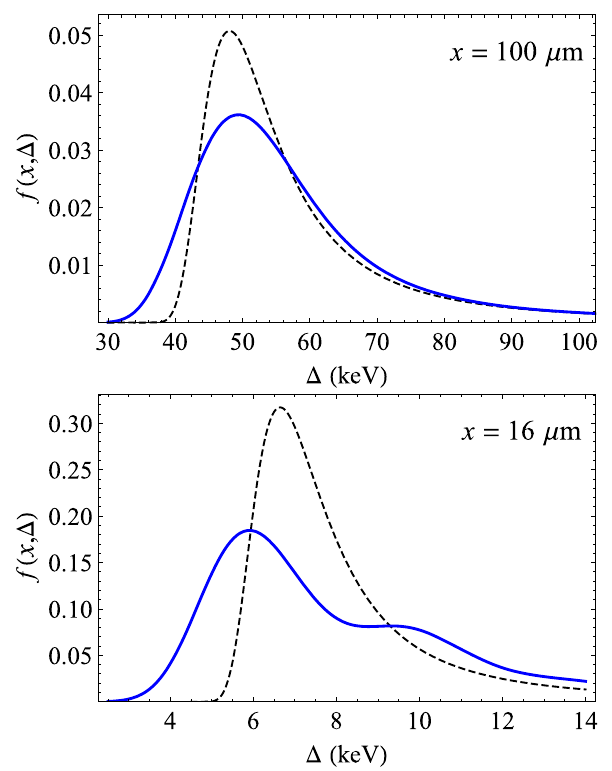
Fig. 2 Straggling functions of a high-energy e + e − pair in a silicon target for two values of the target thickness x . Solid lines – calculation on the basis of (25), dashed lines – on the basis of (11). Separation between the particles in the pair is s = 0 . 5 ω − 1 p